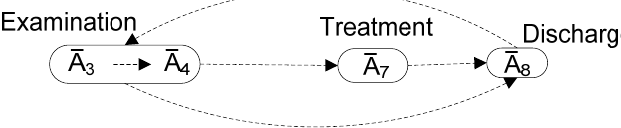
Figure 12. Obstetrician state